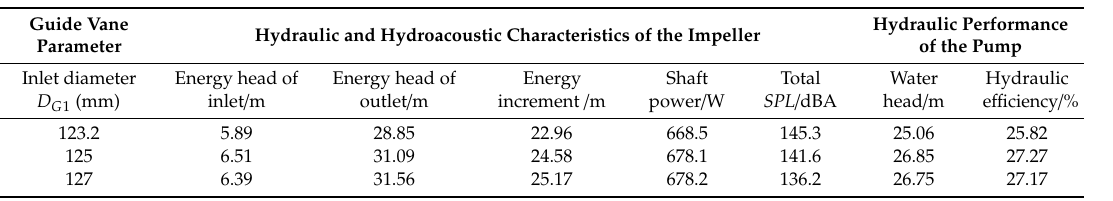
Table 9. Correlations between the inlet diameter of the positive guide vane and the hydraulic and hydroacoustic characteristics of the impeller.